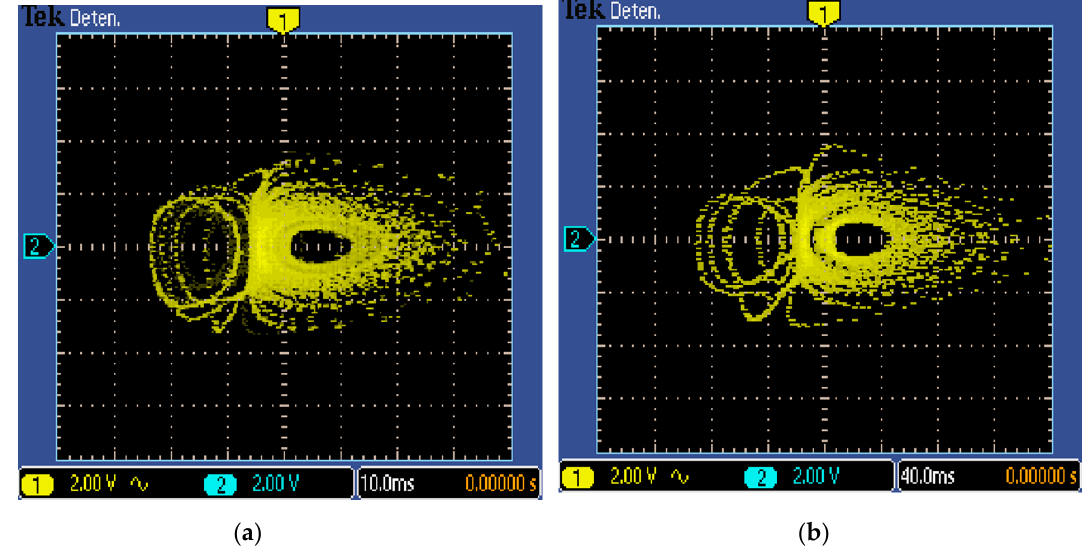
Figure 11. Oscilloscope views in the y - z plane (2v / div) of the new chaotic System (2) implemented in FPGA and with: ( a ) Forward-Euler with h = 0.001 and ( b ) fourth-order Runge-Kutta with h = 0.01.